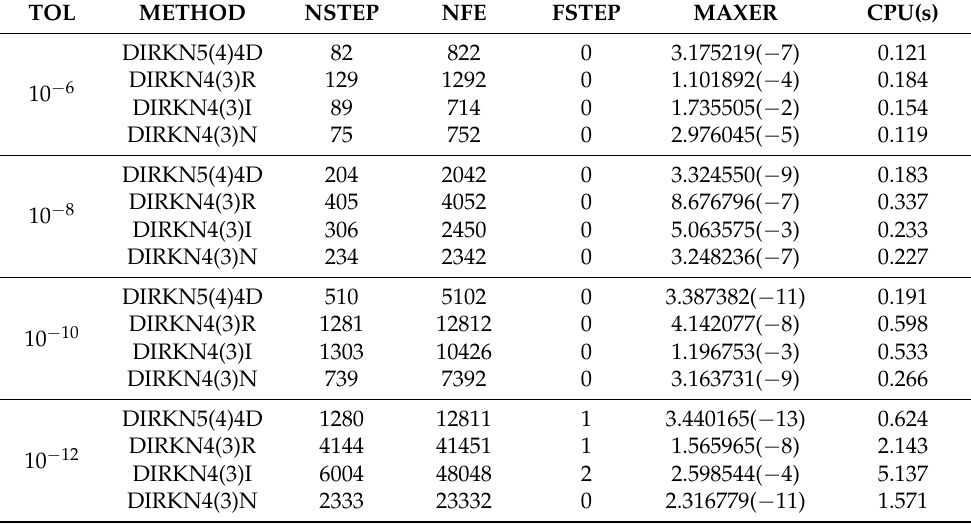
Table 6. Data for Example